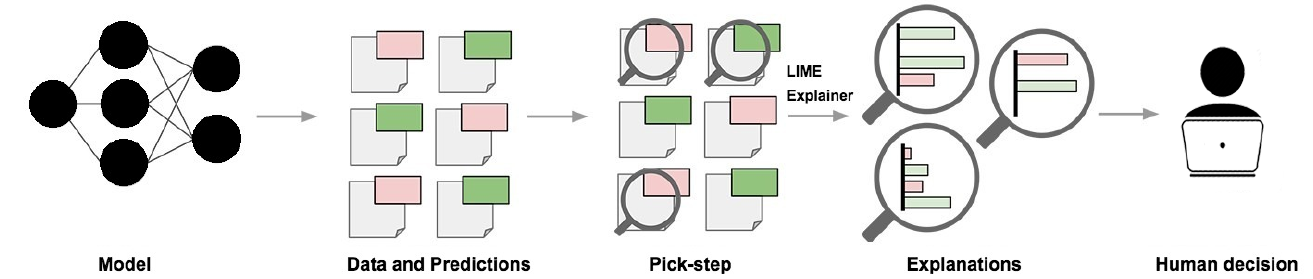
Figure 3. Pipeline of post hoc explainable tool